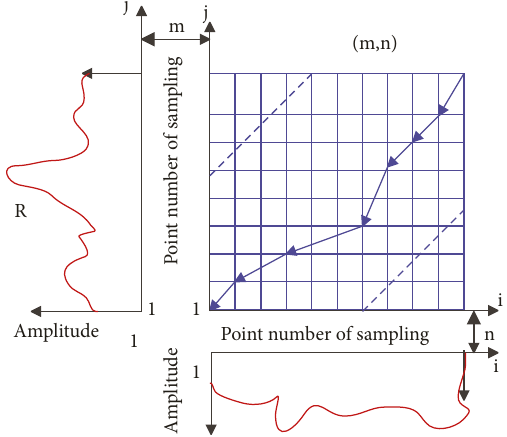
Figure 1: Schematic diagram of the principle of DTW